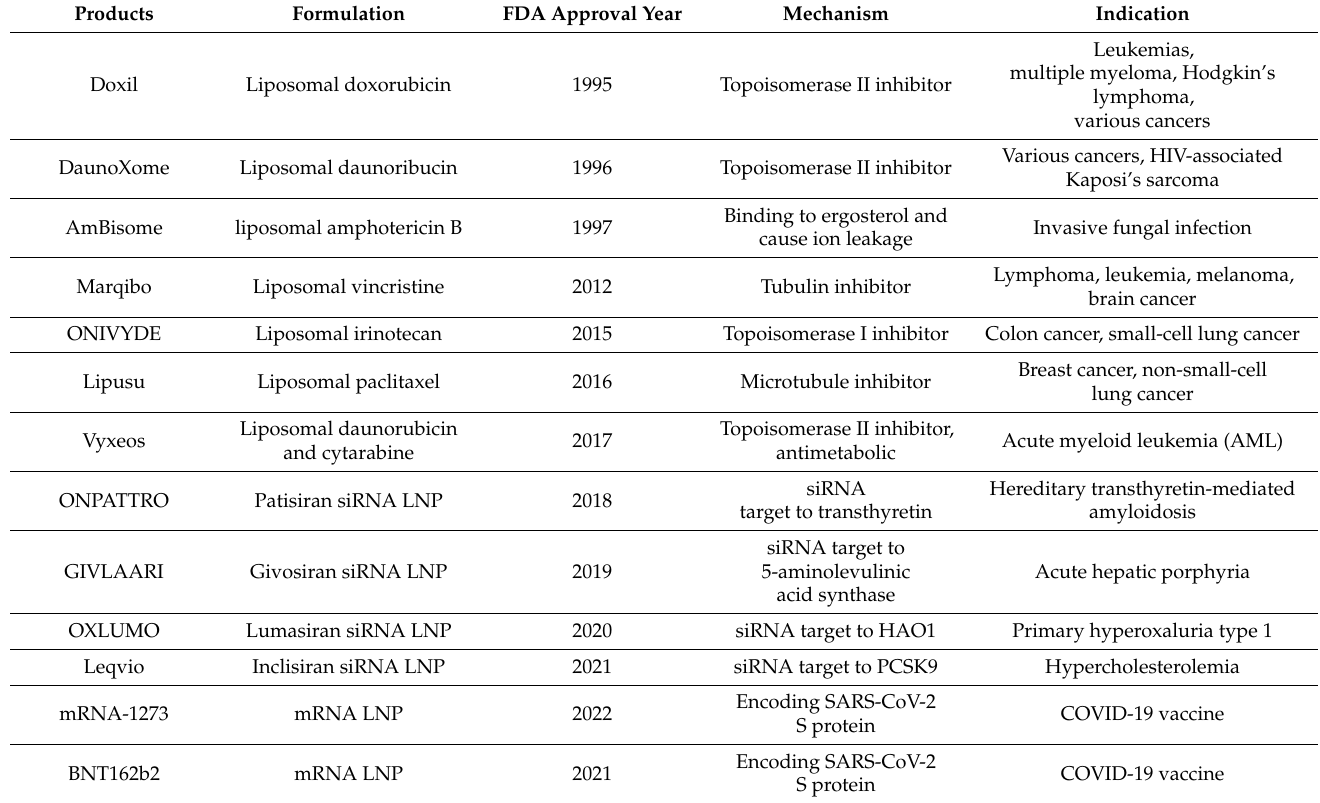
Table 3. FDA-Approved Drugs Encapsulated by Lipid-Based